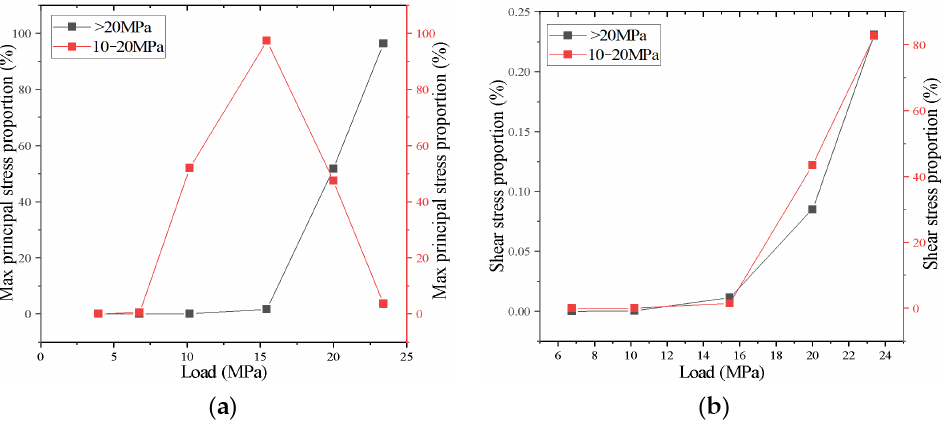
Figure 19. Proportion of maximum principal stress ( a ) and shear stress ( b ) at different pressures. Two points in the 3D model were selected for each matrix (coal, minerals, and near fractures), and Figure 20 shows the corresponding maximum principal stress and shear stress. The different matrices within the sample exhibited significantly different stress states. The maximum principal stresses in the mineral matrix were higher than those in the coal matrix, indicating stress concentration in the mineral regions. By comparison, the stresses in the regions near the fractures were all low.